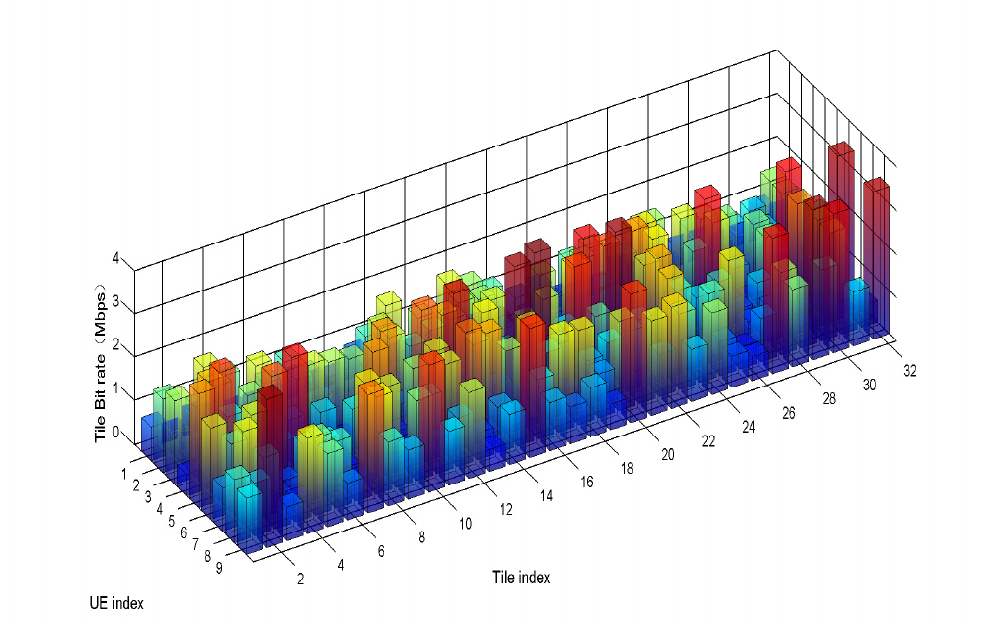
Figure 8. Tile encoding rate of each UE.